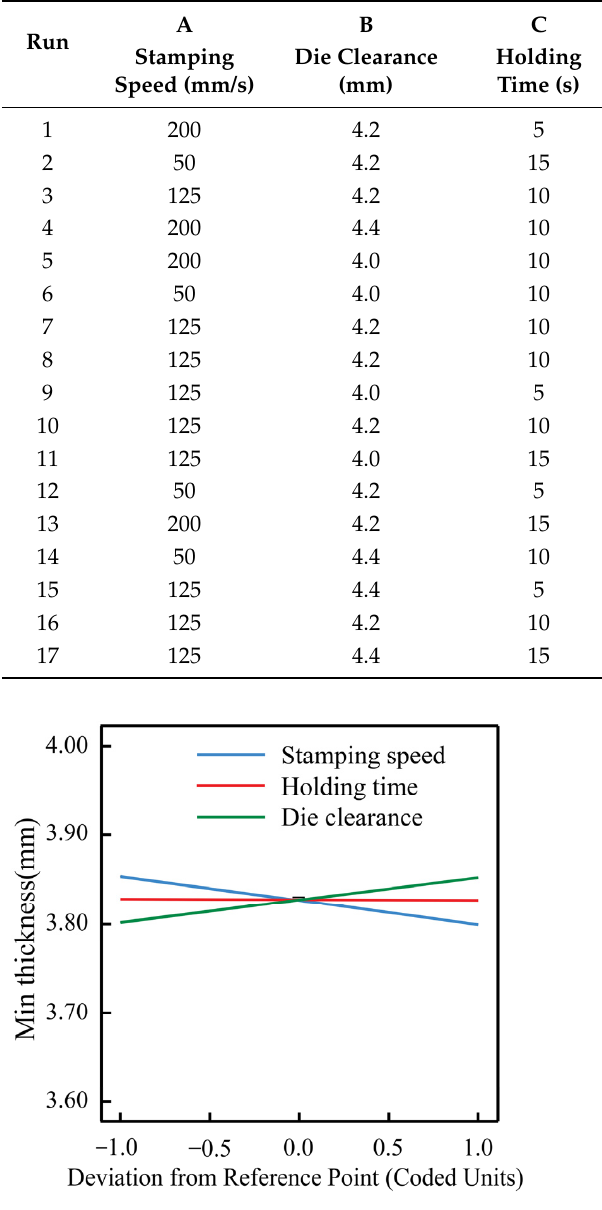
Figure 10. The e ff ect of the single factor on the thickness. Figure 10. The effect of the single factor on the thickness. A quadratic model with an F-value of 14.08 was developed between the springback and the process parameters, as shown in Equation (3). The influence of parameters on springback is complex and the interaction between the factors needs to be considered. The effect of the two-factor interaction on the springback is shown in Figure 11. The springback is related to the temperature distribution of the sheet at the end of the hot stamping. If the temperature of the sheet is low and evenly distributed before opening the mold, then the springback will be